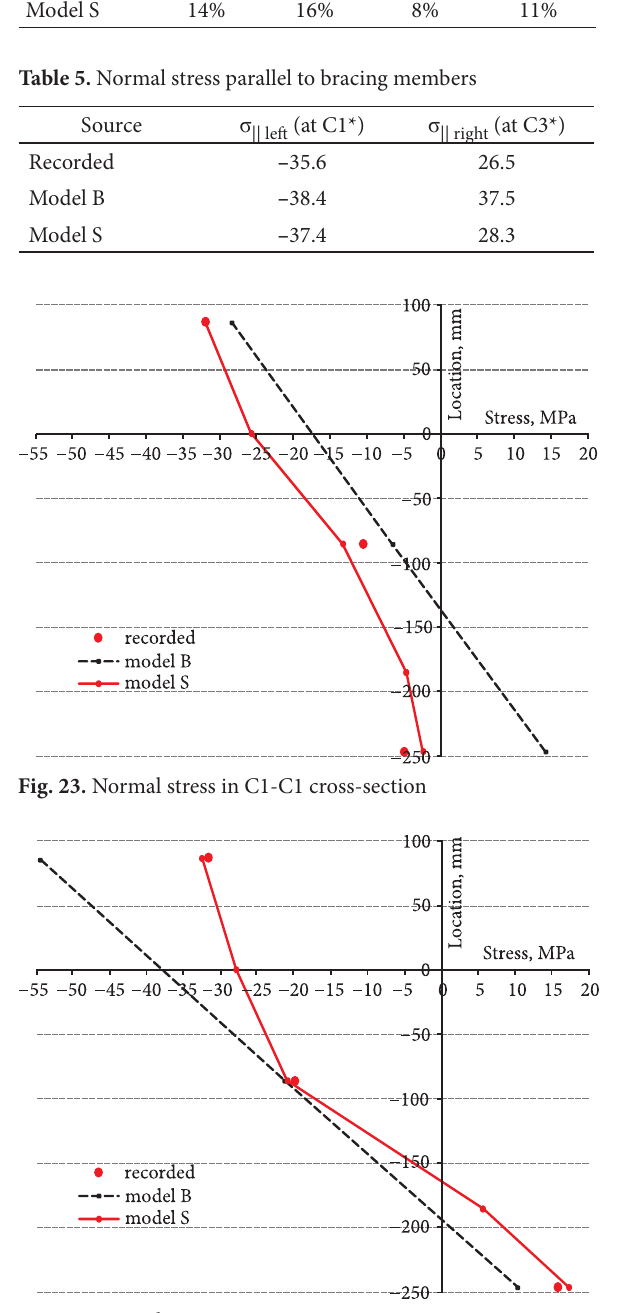
Fig. 24. Normal stress in C3-C3